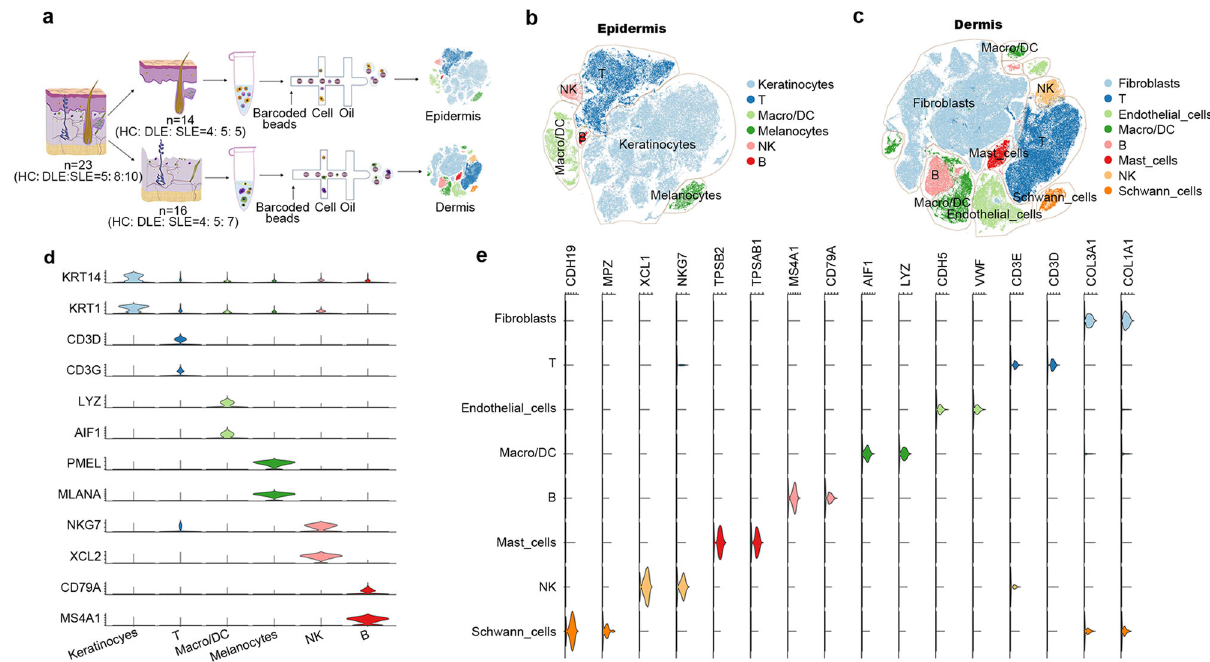
Fig. 1 | scRNA-seq shows the main cell types in epidermis and dermis. a Work fl ow of overall study design. Single-cell RNA sequencing was performed on 14 epidermal samples and 16 dermal samples. b , c t-SNE plots represent the main celltypesidenti fi edinepidermaltissues( b )anddermaltissues( c ).Thesecelltypes were identi fi ed by the speci fi c gene expression shown in Fig. 1d, e, Supplementary